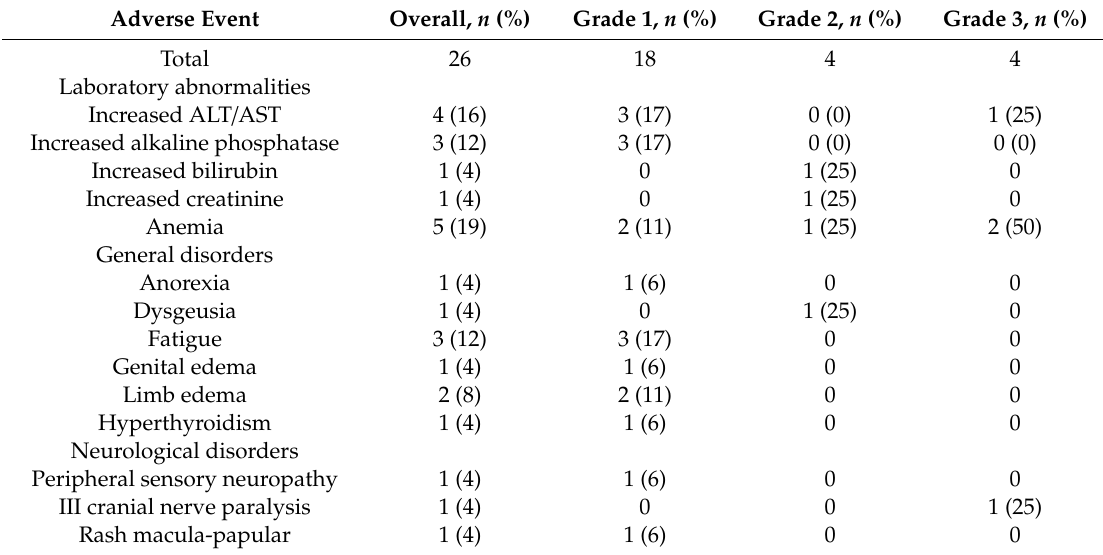
Table 2. Treatment-related adverse